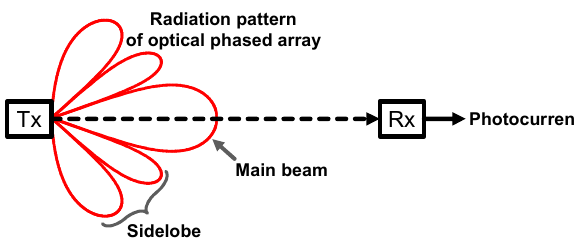
Figure 1. Elements and transmission beam shape of optical wireless communication system based on optical phased array; Tx: transmitter, Rx: receiver.